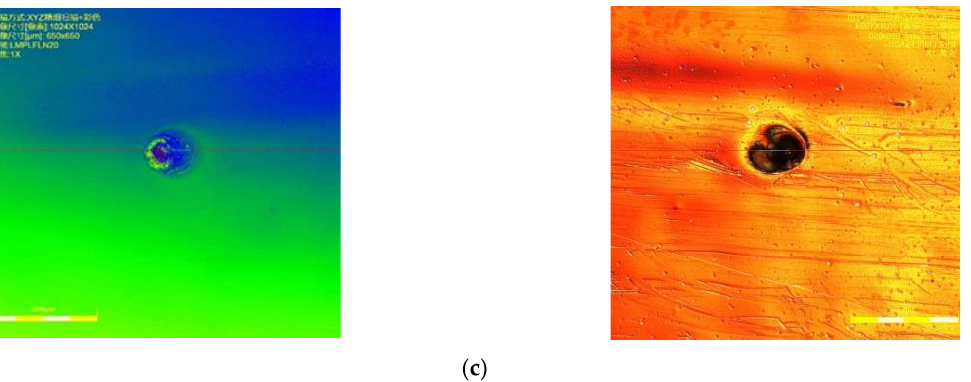
Figure 7. Three-dimensional profiles of the inner wall of pipes with different curvature radii after the erosion experiment. ( a ) Three-dimensional profile of the maximum erosion depth in the central portion of the pipe with a curvature radius of 1.5 m. ( b ) Three-dimensional profile of the maximum erosion depth in the central portion of the pipe with a curvature radius of 3 m. ( c ) Three-dimensional profile of the maximum erosion depth in the central portion of the pipe with a curvature radius of 6 m.